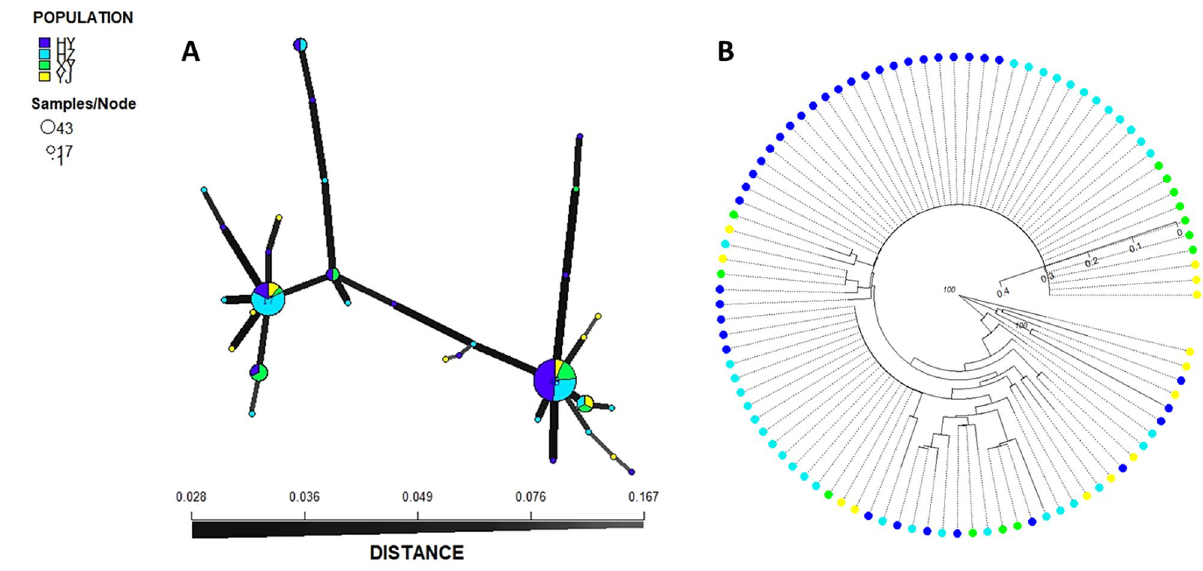
Figure 5. Minimum spanning network (MSN) and neighbour-joining (NJ) tree of 96 P. polysora isolates. Samples are colored according to the cities they were collected from. ( A ) MSN is constructed using the genetic distance of Bruvo. All the mutilocus genotypes are shown as a circle. The circle scale shows the number of isolates sharing the same mutilocus genotype. The ratio of colors in each circle is proportional to the ratio of isolates collected in different cities with the same mutilocus genotype. ( B ) Neighbour-joining (NJ) tree of 96 P. polysora isolates. Only values greater than 75 are shown based on 999 bootstraps